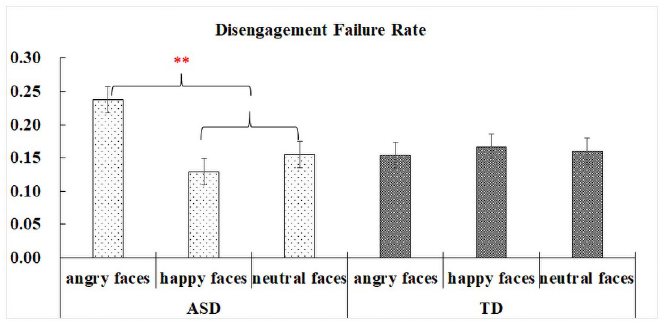
Fig 5. Interactions between group and distractor type on disengagement failure